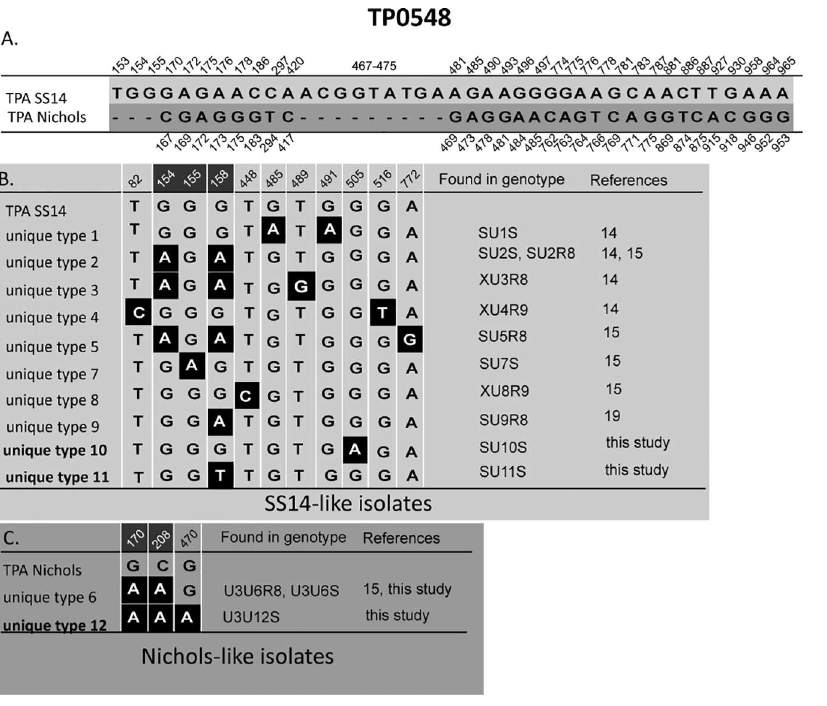
Fig 3. Alignment of all TP0548 unique sequencesidentified to date [this study, 14, 15, 19]. Only positionscontaining nucleotidevariants are shown. A. Nucleotidedifferences betweenreference strain TPA SS14 and TPA Nichols in the regioncharacterized using SBMT (at coordinates 16–1080of TPANIC_0548; CP004010.2). Coordinatesshownabovecorrespond to TPASS_0548 (TPA SS14; CP004011.1) and coordinates shown belowcorrespond to TPANIC_0548 (TPA Nichols;CP004010.2). B. Nucleotide differences in SS14-likeuniquesequences. Coordinates correspond to TPASS_0548 (TPA SS14; CP004011.1). New uniquesequencesidentifiedin this study are shown in bold. The white lines betweencoordinatesindicatethe non-continuous nucleotidepositions.Highlighted coordinates shownin white (154, 155, 158) correspond to regionsdetermined by ECDCT. C. Nucleotide differencesin Nichols-likeuniquesequences.Coordinates correspond to TPANIC_0548(TPA Nichols;CP004010.2). New uniquesequenceidentifiedin this study is shownin bold. The whitelines between coordinates indicatethe non-continuous nucleotidepositions. Highlighted coordinatesshownin white(170, 208) correspond to regionsdetermined by